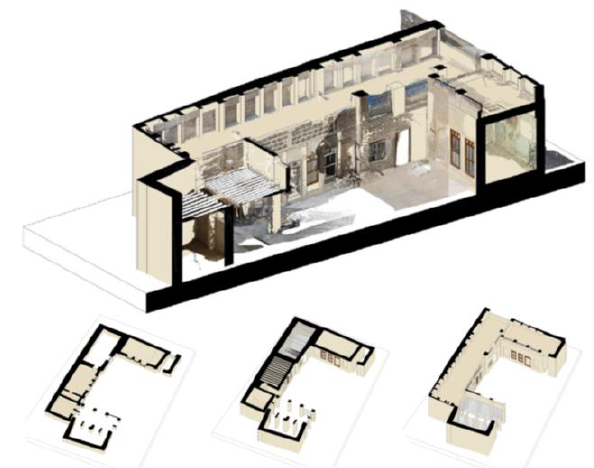
Figure 12 Sectioned views of the BIM model of the Aljazzaf house. The model was generated from the pointcloud. Software employed Autodesk Revit 2016. Images source Authors and Marwa Reyadh Alarayedh.